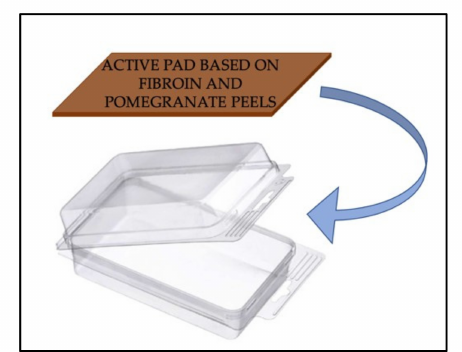
Figure 1. Representation of potential future applications of developed active